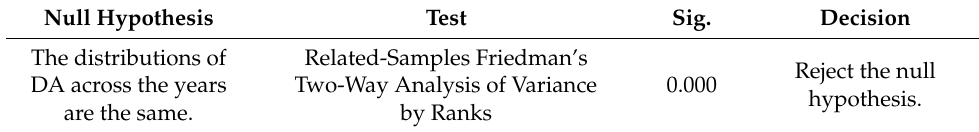
Table 8. Friedman test (distribution of discretionary accruals levels across